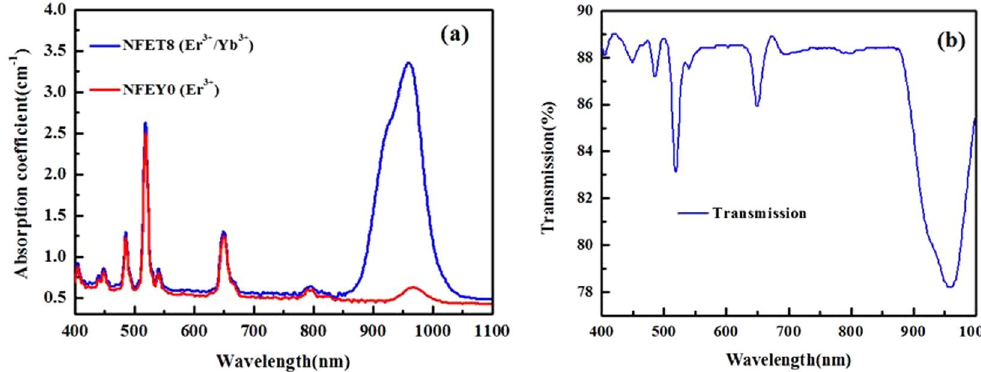
Figure 2. ( a ) Absorption spectra of Er 3 + /Yb 3 + single doped and co-doped Na 5 Lu 9 F 32 single crystals. ( b )